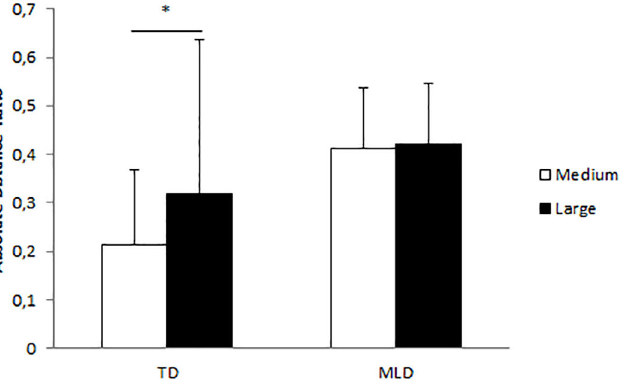
Figure 2. TD and MLD performances on Symbolic-to-Analogic number transcoding tasks (error bars = standard deviation).